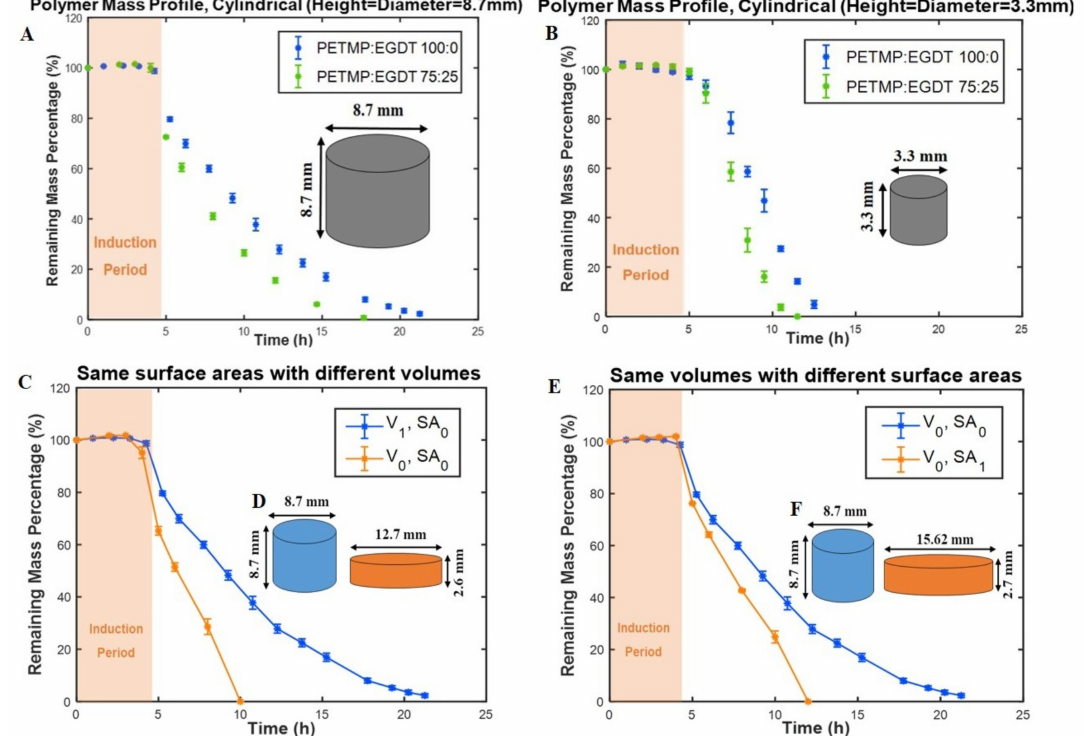
Figure 3. The e ff ect of geometry on the mass loss profile of polymers. Percentage mass remaining for ( A ) big (SA / V ratio = 0.69 mm –1 ) and ( B ) the small (SA / V ratio = 1.82 mm –1 ) cylindrical tablets. ( C ) Remaining mass percentage of two tablets with the same surface areas and di ff erent volumes (V 1 = 1.36 V 0 ). ( D ) Schematics of tablet designs and dimensions (SA / V ratio (blue) = 0.69 mm –1 , and SA / V ratio (orange) = 1.08 mm –1 ). ( E ) Remaining mass percentage of two tablets with the same volumes and di ff erent surface areas (SA 1 = 1.44 SA 0 ). ( F ) Schematics of tablet designs and dimensions (SA / V ratio (blue) = 0.69 mm –1 , and SA / V ratio (orange) = 1.00 mm –1 ). All experiments were conducted at 37 ◦